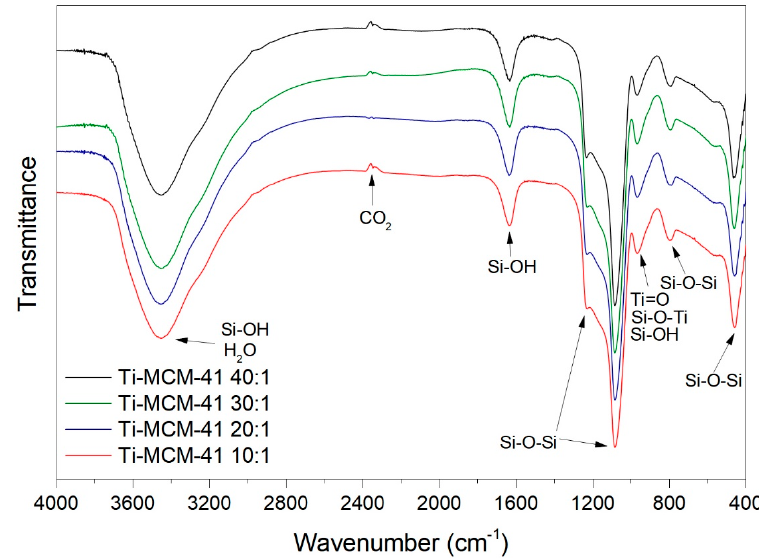
Figure 5. FT-IR spectra of Ti-MCM-41 catalysts with different molar ratios of Si:Ti in the crystallization gel (respectively, 40:1, 30:1, 20:1, and 10:1).